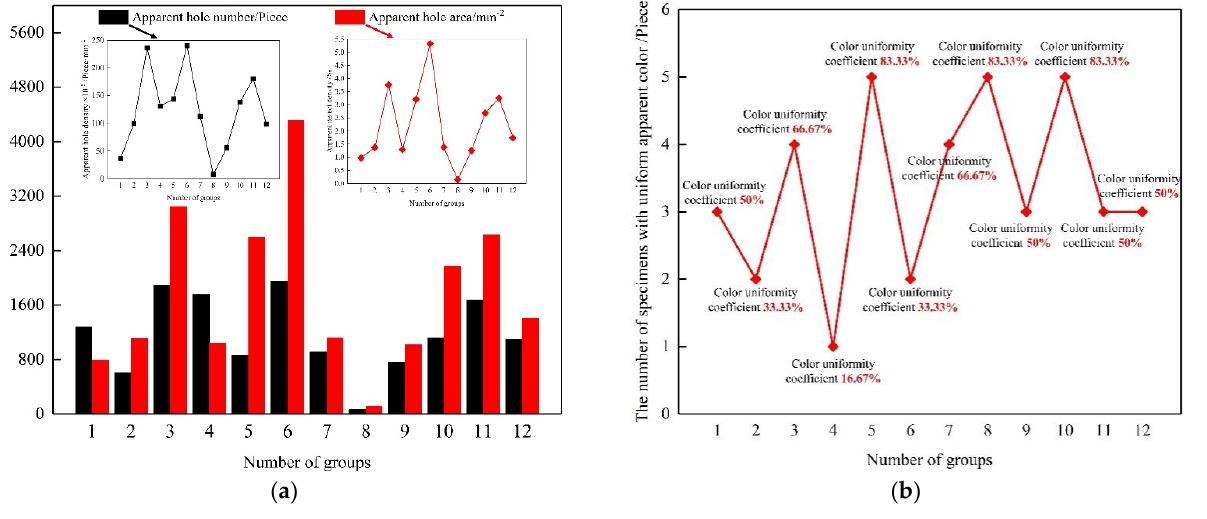
Figure 12. Statistical results of apparent quality parameters of SCFFC. ( a ) Statistical results of apparent hole number and apparent hole area. ( b ) The number of specimens with uniform apparent